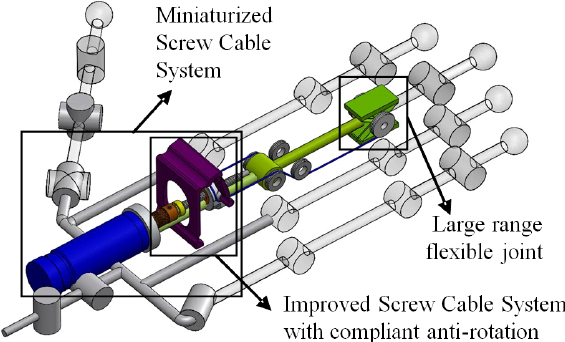
Figure 18. Perspective of integration of the proposed transmission within the context of an anthropomorphic robot